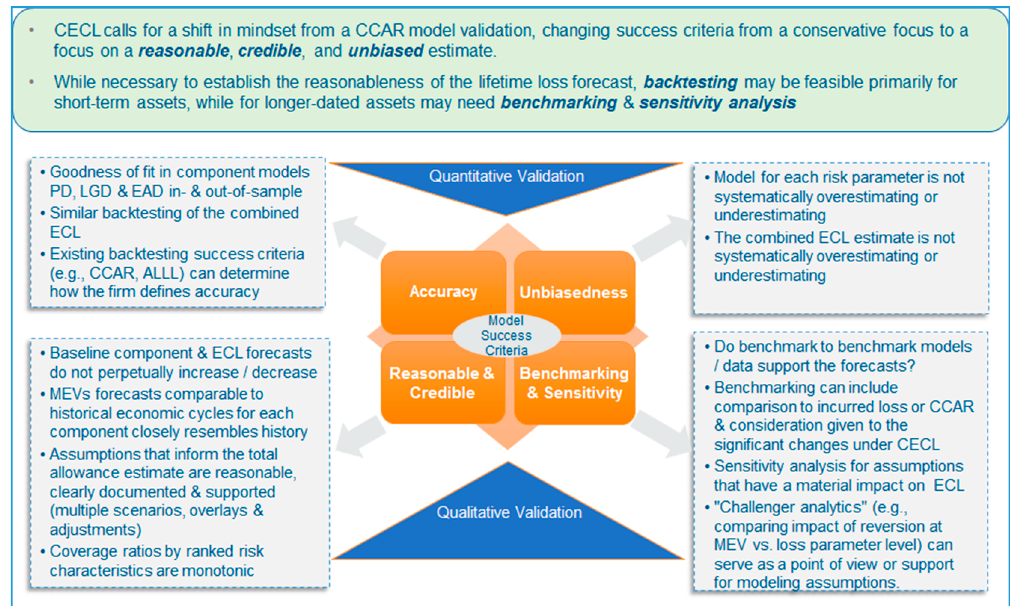
Figure 3. Challenges in the validation of Current Expected Credit Loss (CECL) model development—benchmarking and backtesing.